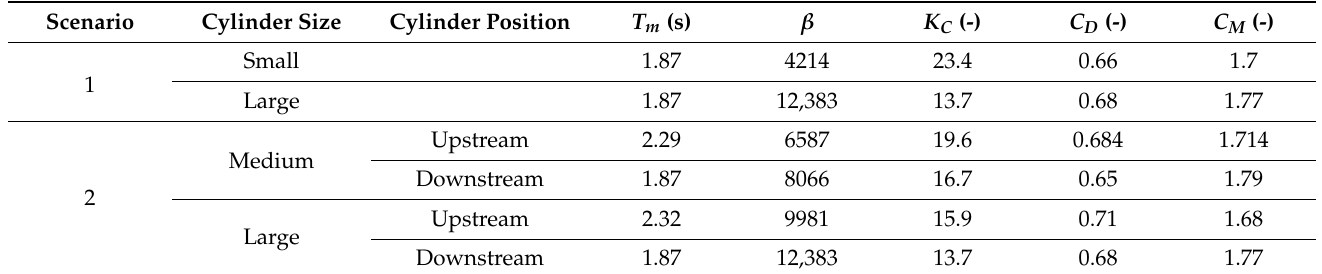
Table 6. Wave periods, β and K C values, and extracted drag and inertia coefficients for the first and second scenarios.